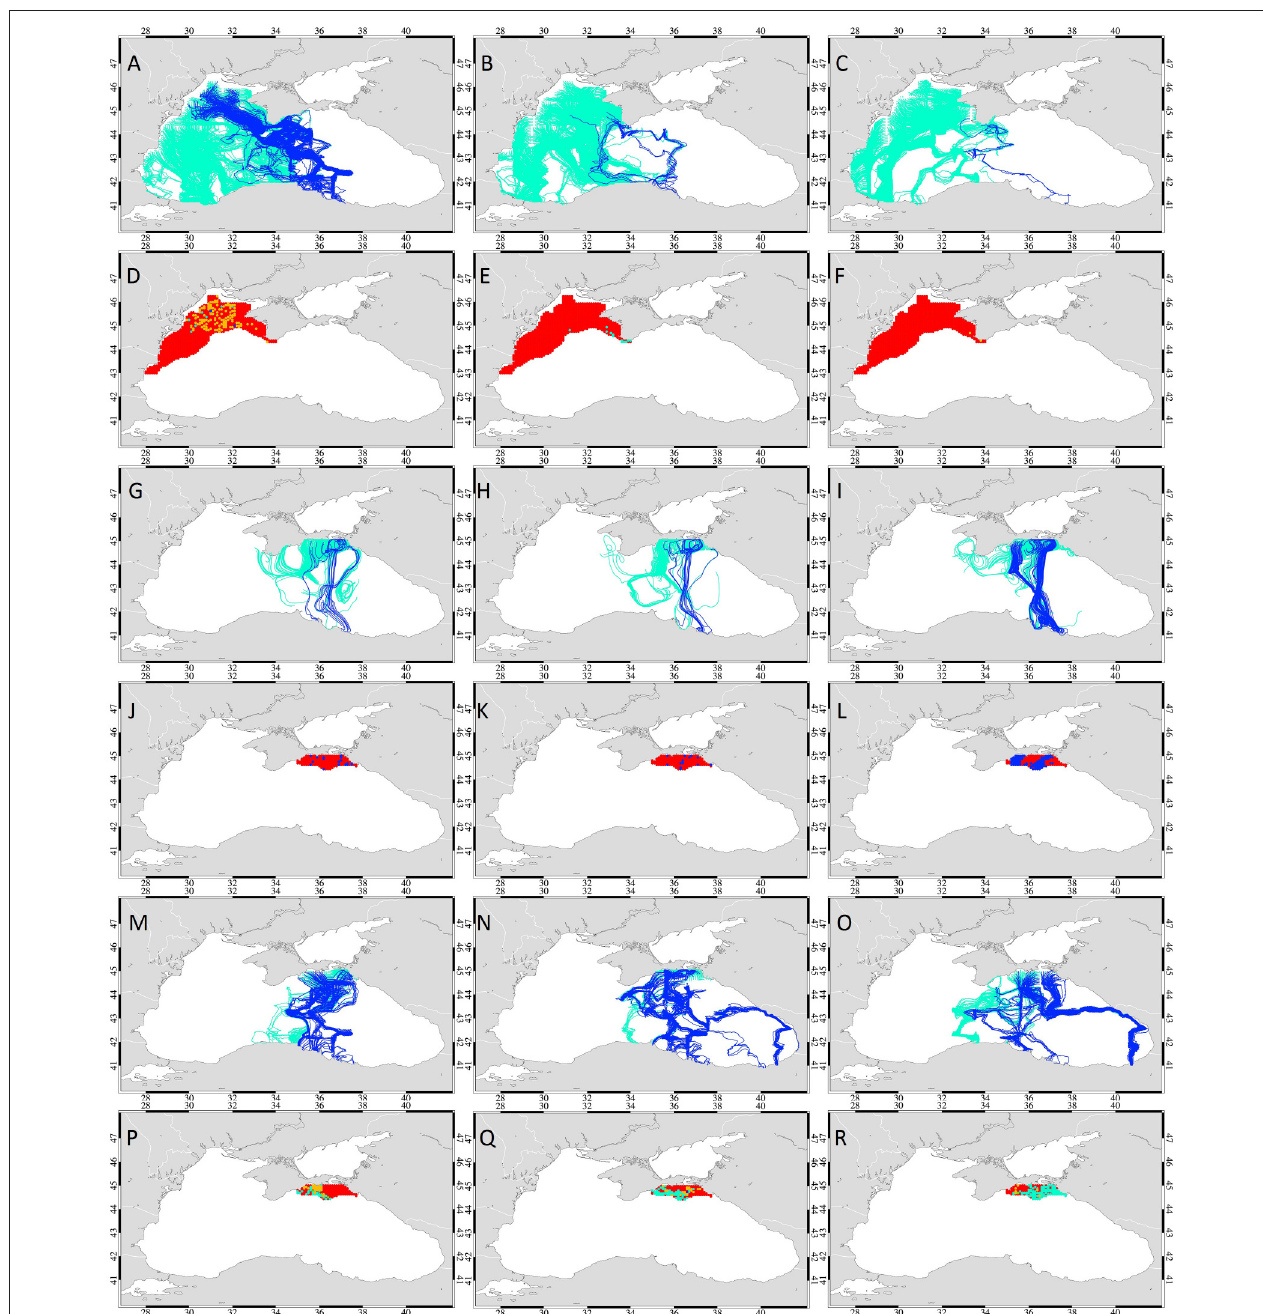
FIGURE 10 | Simulations of seasonal variability: The paths (A–C) and start points (D–F) of drifters released on the northwestern shelf in temperature gradient simulations. Further, the paths of drifters (G–I) and start points (J–L) released at Kerch Strait exit area in the advection only simulations and the paths (M–O) and start points (P–R) of drifters released at Kerch Strait exit area in the temperature gradient simulations. Release times were September 15th, 30th and October 15th in 2003 (left, middle, and right column). The paths of drifters reaching the overwintering area in 2 months are marked blue, the ones that do not reach are in green. The start points of drifters that complete a successful migration in 2, 4, 6, and 8 weeks are color-coded green, cyan, yellow, and dark blue, respectively. The start points of the drifters that do not reach the overwintering grounds are marked